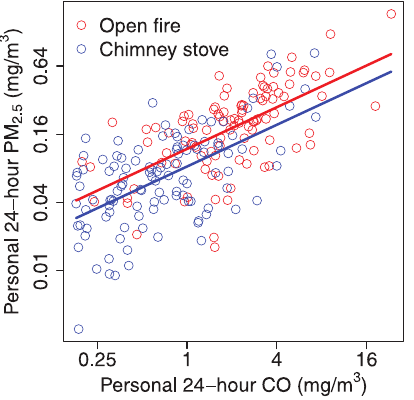
Figure 1. Scatter plot of simultaneous 24-hour personal fine particles (PM 2.5 ) and personal carbon monoxide (CO). Lines for each stove type (red for open fire, blue for chimney stove) using equation PM 2.5 =e ( 2 2.13 + 0.61*ln(CO) 2 0.36*chimney ) estimated from linear mixed effects regression model with natural log-transformed exposures (216 measurements among 116